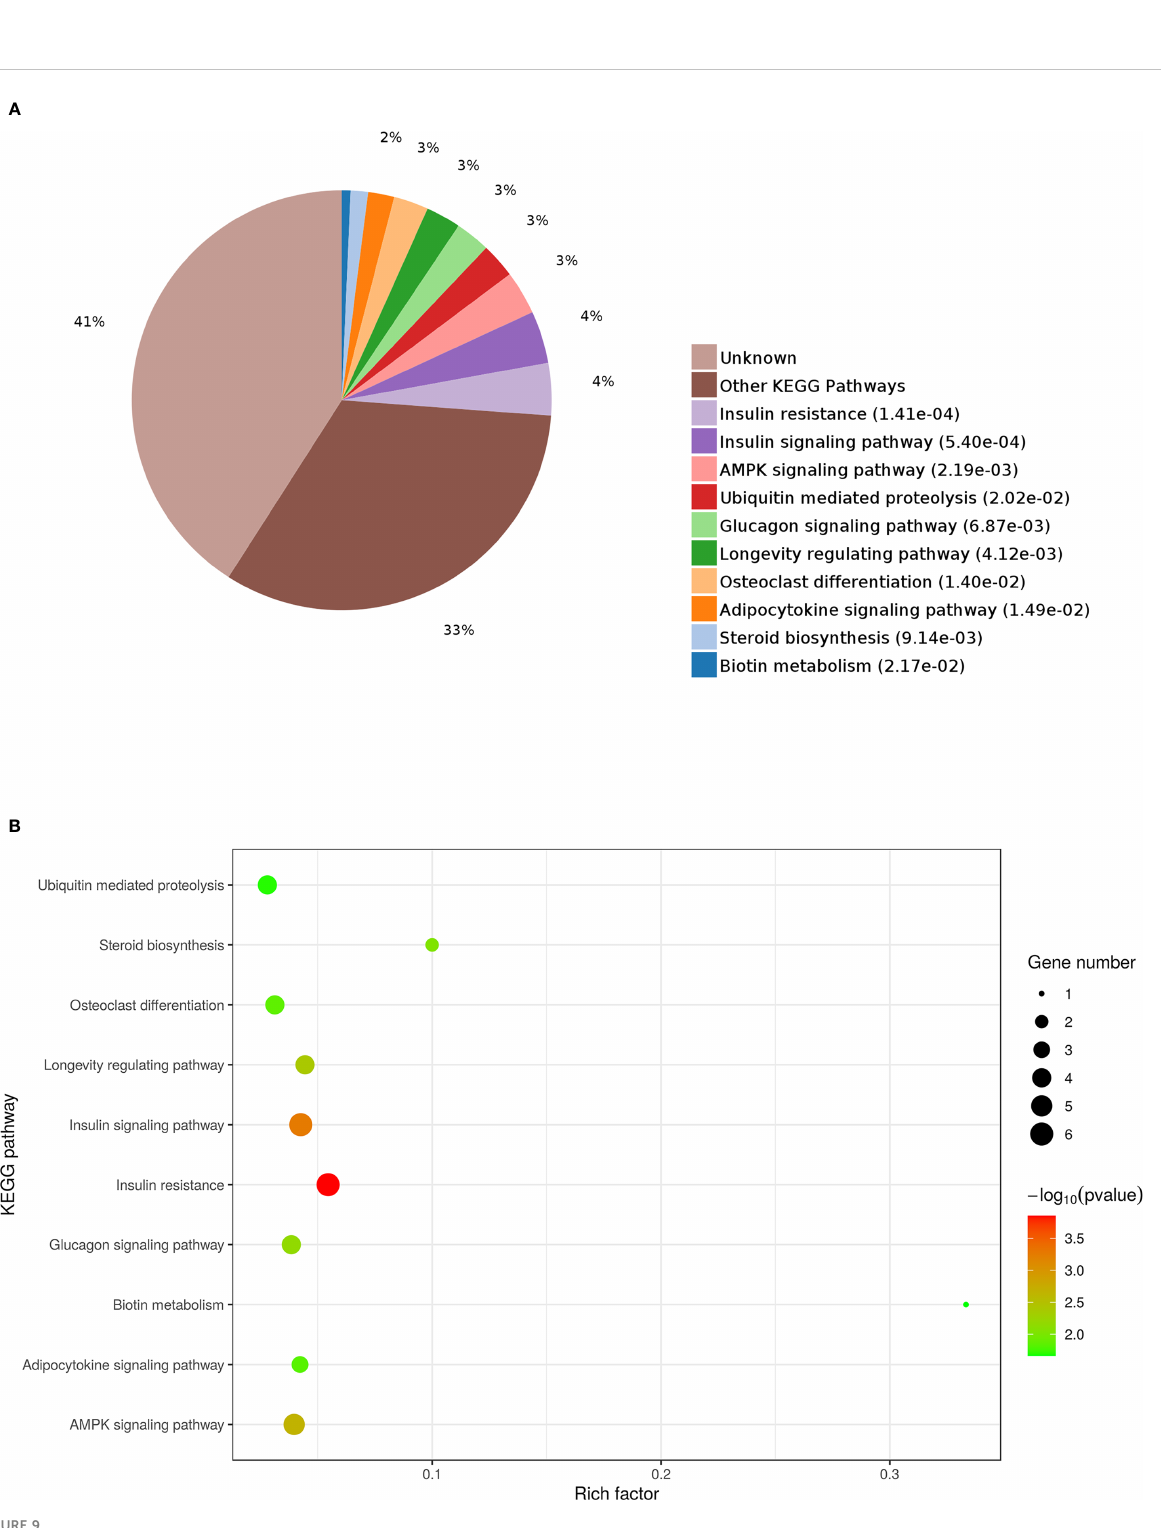
FIGURE 9 Kyoto Encyclopedia of Genes and Genomes (KEGG) pathway analysis of DEPs. (A) Pie chart of DEP-enriched KEGG pathways. (B) KEGG pathway enrichment distribution of